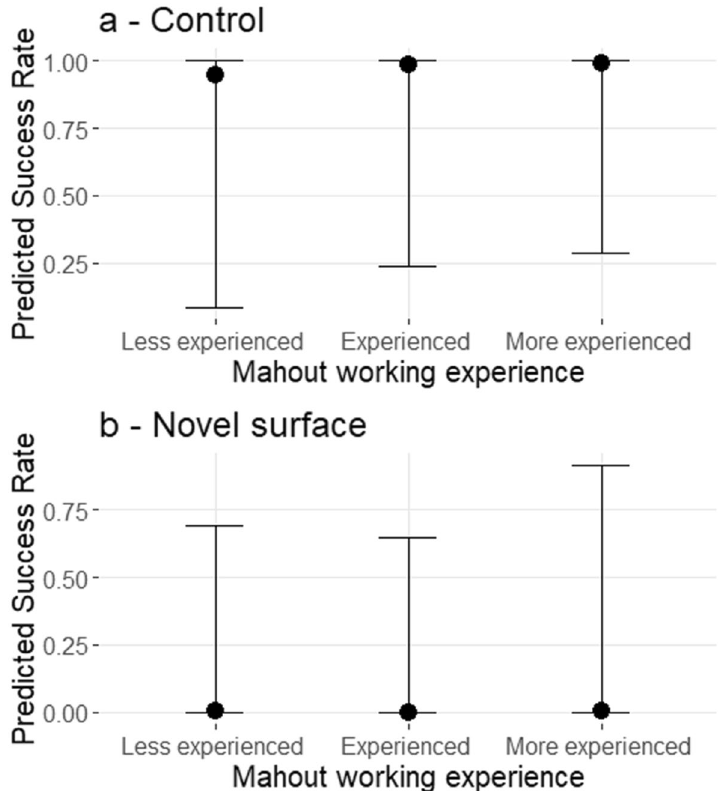
Figure 3. Predicted success rate depending on mahout working experience. ( a —control, b —Novel surface). Bars represent the 95% credibility intervals. (Bayesian regression models from Table 2).